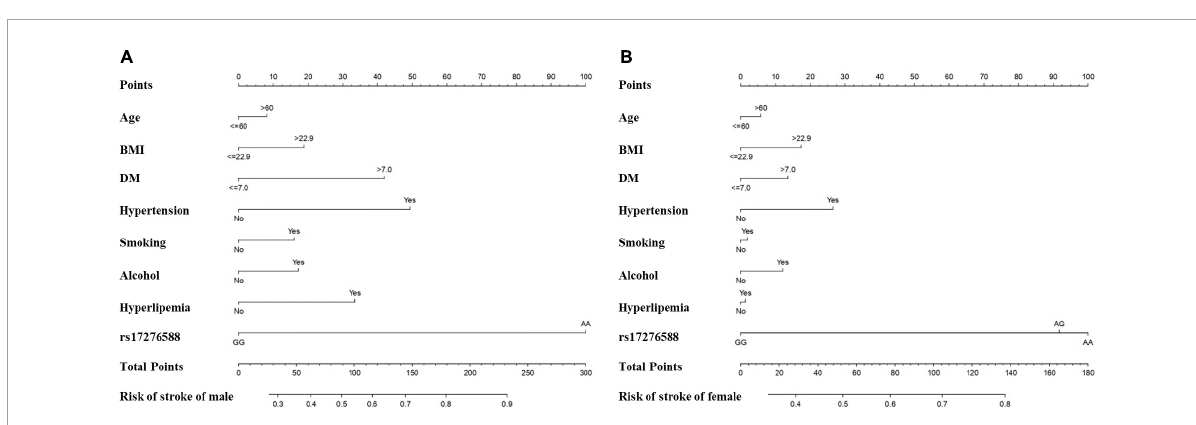
FIGURE5 Nomogram for predicting the incidence of IS among the male (A) female (B) populations. The features included in the nomogram were age, BMI, DM, hypertension, smoking, alcohol, hyperlipemia, and rs17276588. (DM, Diabetes mellitus; BMI, body mass